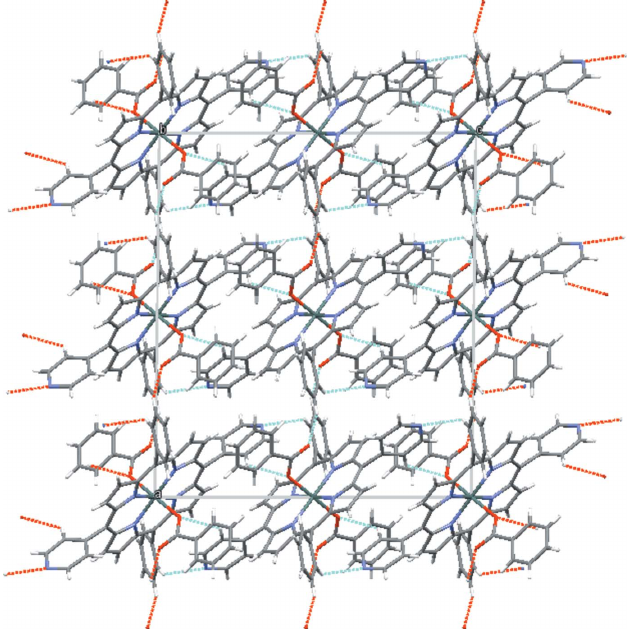
Figure 2 View of the packing of the molecular components in the title compound in a view along [010]. Red and cyan lines represent intermolecular hydrogen bonds (Table 2).